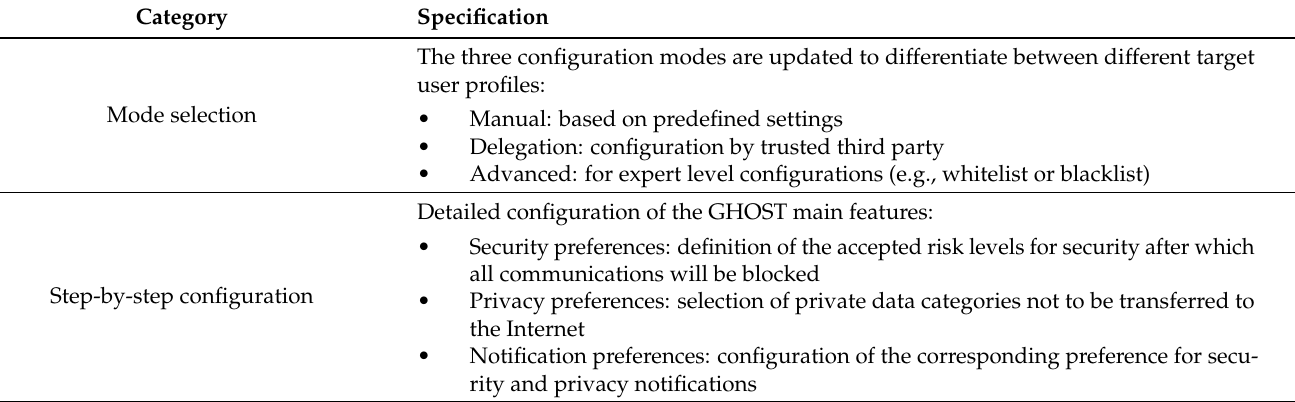
Table 11. Configuration interface: updates to the initial